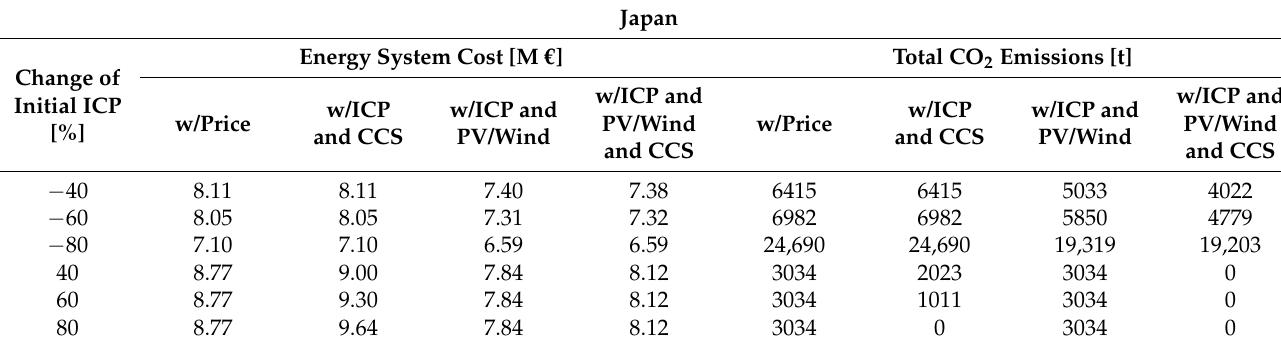
Table A2. Sensitivity analysis results for the Japanese scenarios.